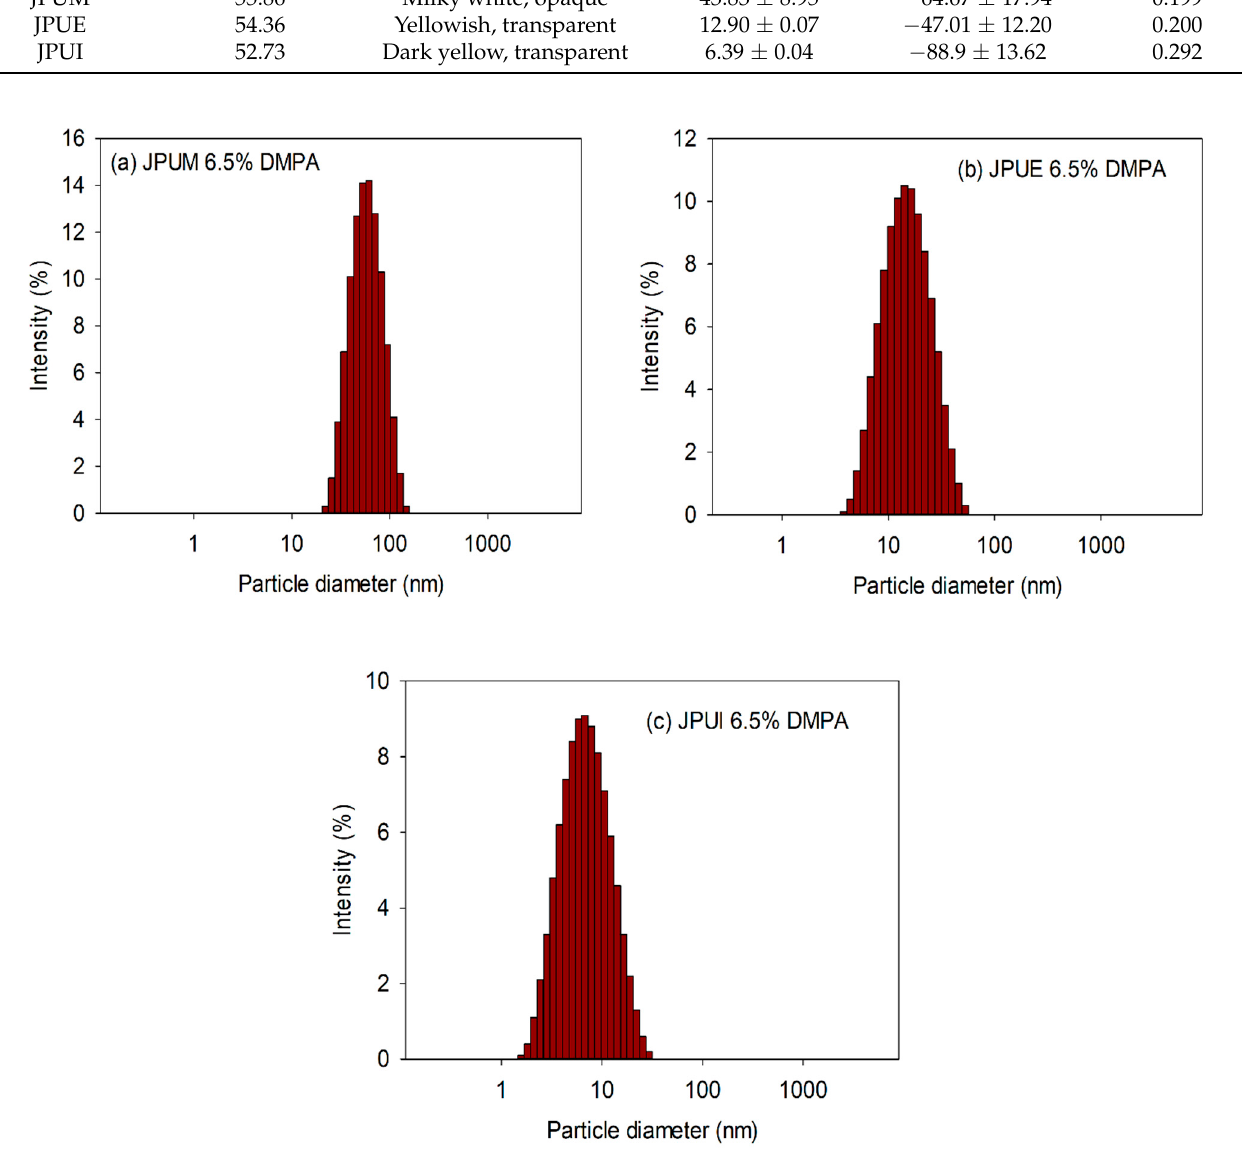
Figure 8. Particle size distribution and zeta potential of all JPU